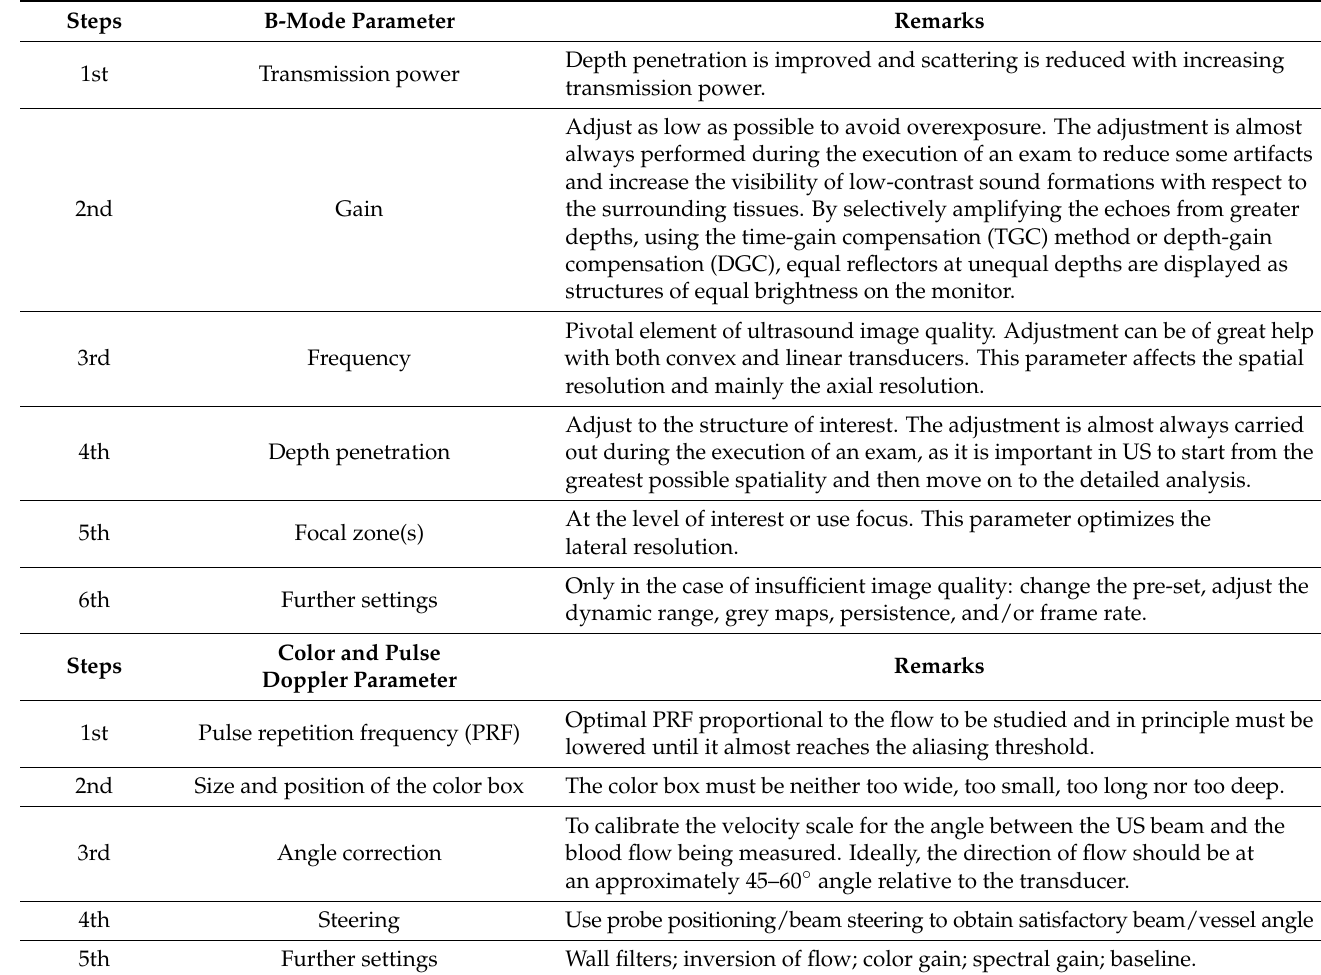
Table 2. Steps to achieve optimal settings for B-Mode and Doppler US. Modified from Zander D et al.